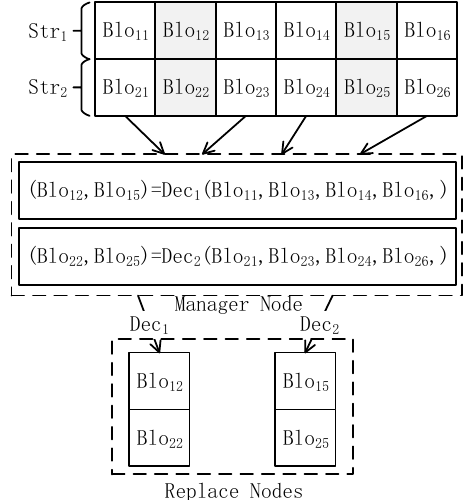
Figure 1. Transmission and Repair Process in Single Manager Repair (SMR).